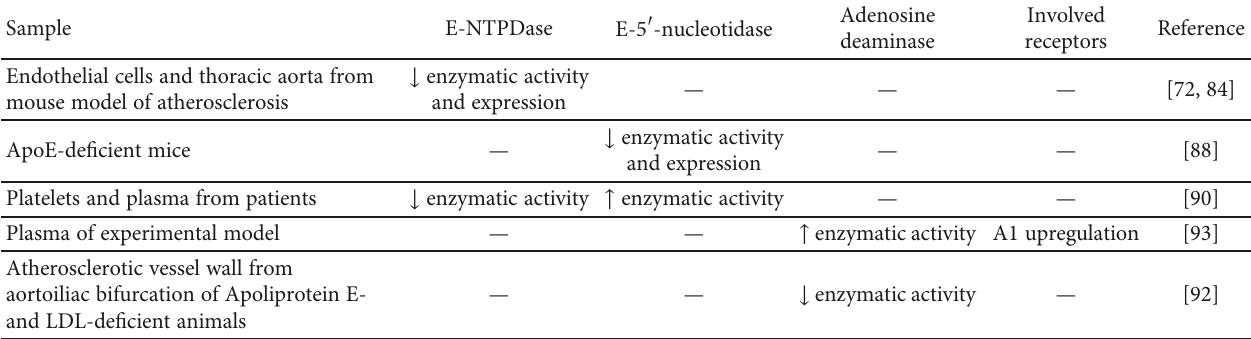
Table 1: Ectonucleotidases (E-NTPDase, E-5 ′ -nucleotidase, and ADA) and purinergic receptors in experimental models and patients with